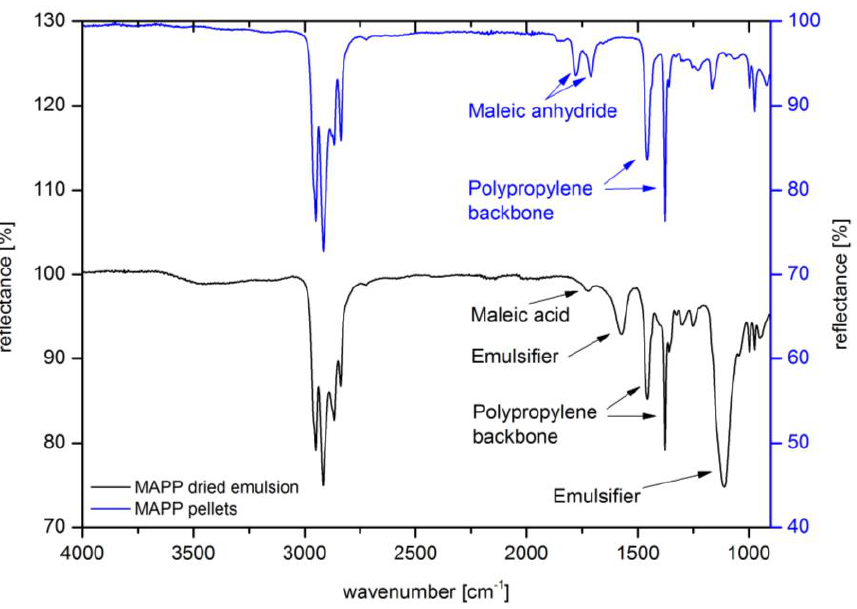
Figure 10. Fourier-Transform Infrared (ATR-FTIR) spectra of MAPP in solid and emulsified forms. To verify that emulsified MAPP was present on the TMP, ATR-FTIR spectra for the treated and untreated fibres were taken. Untreated fibres display ester groups which absorb near 1730 cm − 1 , so the confirmation of ester links may be indicated by an increase in the intensity of the absorption bands near 1730 cm − 1 [42]. These absorption bands may be associated with carbonyl (C=O) stretching of acetyl and carboxyl groups in hemicelluloses and lignin, aldehyde in lignin and extractives, and also of esters in lignin and extractives [42]. However, no significant differences were observed near 1730 cm − 1 in the spectra of Robinia and Scots pine fibre surfaces with and without liquid MAPP (results not shown). Kazayawoko et al. [42] also found no differences in the FTIR spectra of TMP with and without MAPP. They proposed that the absence of esterification between TMP and MAPP may be due to the presence of lignin on the fibre surface and due to the long polypropylene chains attached to the short anhydride ring (steric hindrance of